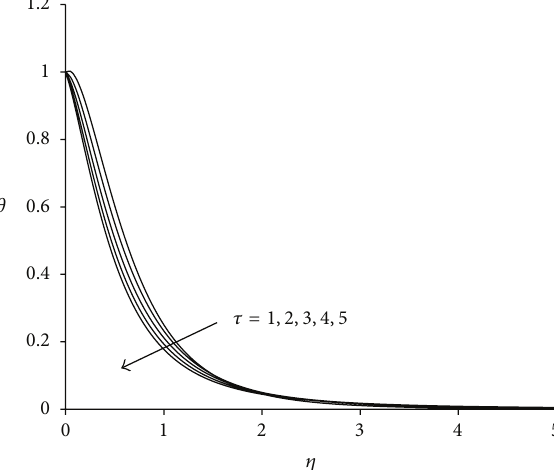
Figure 5: Velocity distribution for different 𝜏 (𝜆 = 3, 𝜎 = 3, Ec = 0.75) .